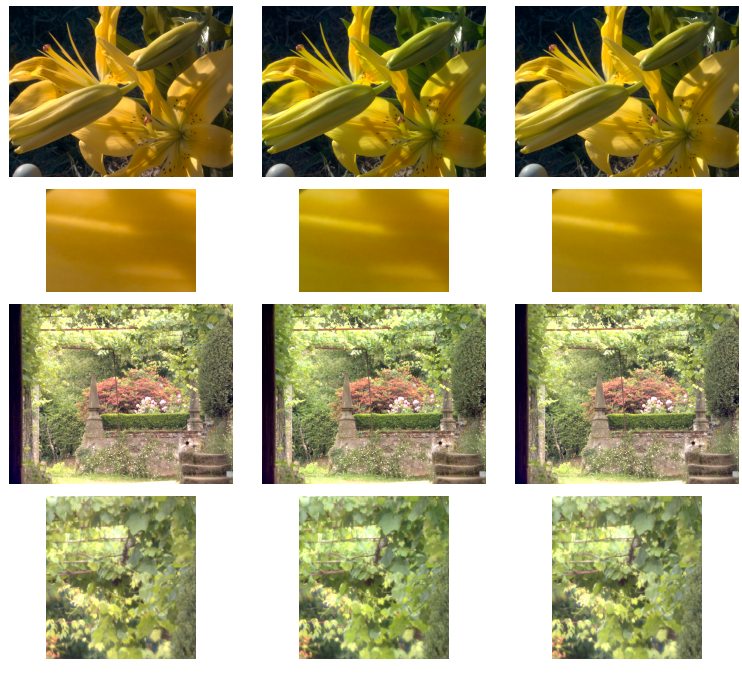
Figure 13. Qualitative evaluation of the approach. Top two rows, minimizing the S-CIELAB measure: full image ( top column ) and detail ( second row ). Last two rows, minimizing the CID measure: full image ( third row ) and detail ( last row ). For each column the images are: original ( left ), least-squares ( center ) and spherical sampling ( right